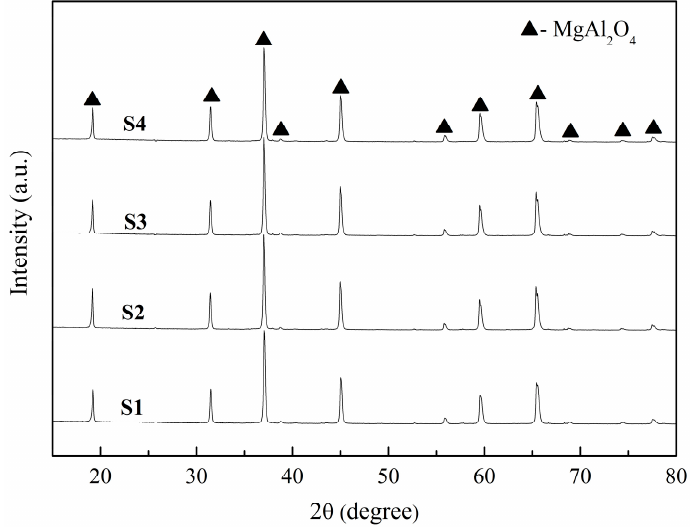
Figure 3. XRD patterns of the samples with different ratios of starting powders and deionized water sintered at 1600 °C for 4 h.